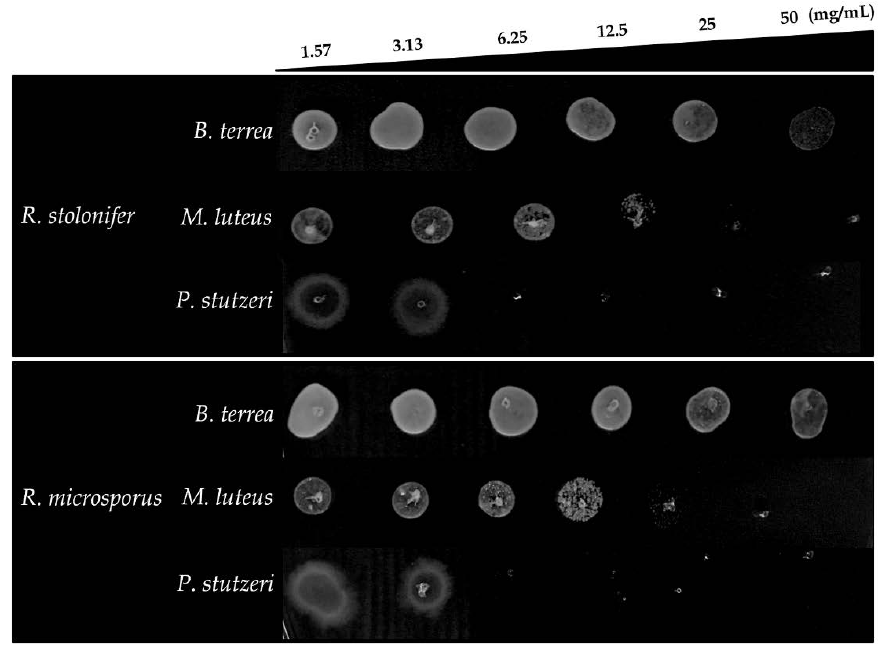
Figure 3. Minimal Bactericidal Concentration (MBC) of CMHs from Rhizopus species against B. terrea , M. luteus and P. stutzeri analyzed by dot spot technique.